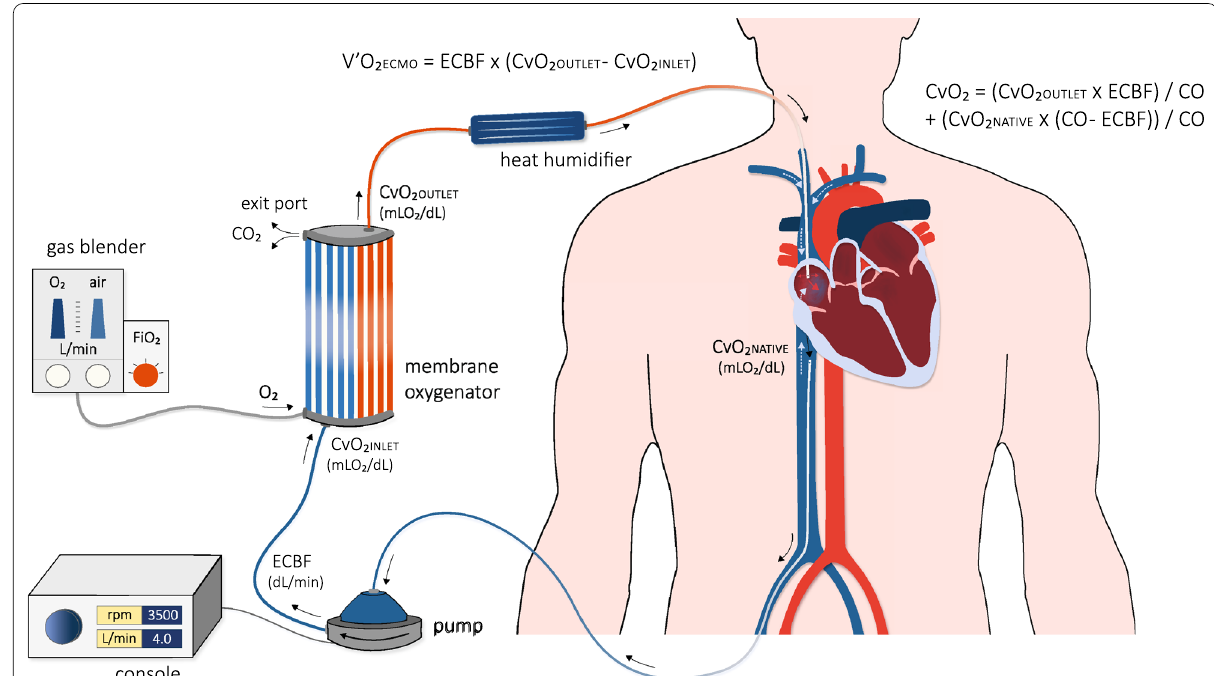
Fig. 1 Illustration of the ECMO technique and physiology of gas exchange (see main text for a detailed description). Venous blood is drawn via a central venous catheter inserted in the femoral vein, which is propelled at a set extracorporeal blood flow (ECBF) rate to a membrane oxygenator where gas exchange takes place. Gas with a user-adjusted fraction of O 2 enters the oxygenator in order to saturate the hemoglobin of the venous blood. CO 2 diffuses from the venous blood to the gas and leaves the oxygenator via an exit port. Heated and humidified oxygenated blood is then returned to the venous circulation via the jugular vein. V’O2 ECMO reflects the amount of oxygen delivered by the ECMO system and is depending on the ECBF and the oxygen content in the blood before (CvO 2INLET ) and after (CvO 2OUTLET ) the membrane oxygenator, respectively. White arrows in the subclavian veins and vena cava indicate native venous return; the oxygen content of the native system (CvO 2NATIVE ) is mixed with the oxygenated blood from the ECMO system. The arterial oxygen content of the mixed blood (CvO 2 ) is described by Equation 2 and depends on the ratio of ECBF to cardiac output (CO 2 ). CO, cardiac output; CO 2 , carbon dioxide; CvO 2 , oxygen content in venous blood; ECBF, extracorporeal blood flow;